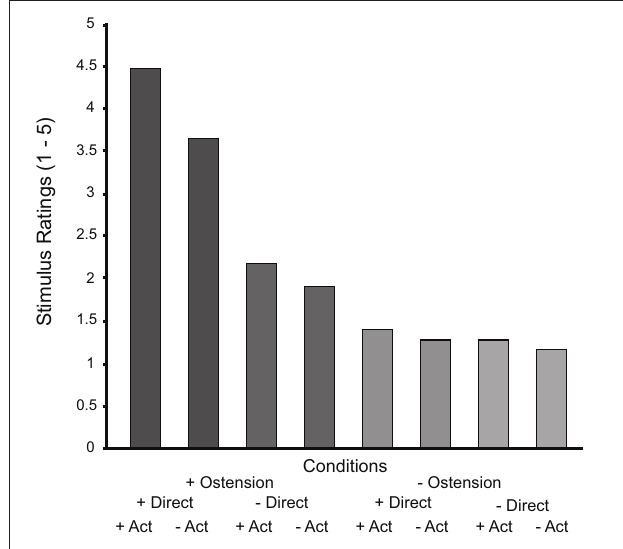
FIGURE 2 | Results from the post-scan stimulus ratings sorted by condition. Notice that the graph summarizes the “within-subject” results across all subjects and therefore we have not included error bars (between subject variance would not reflect the actual